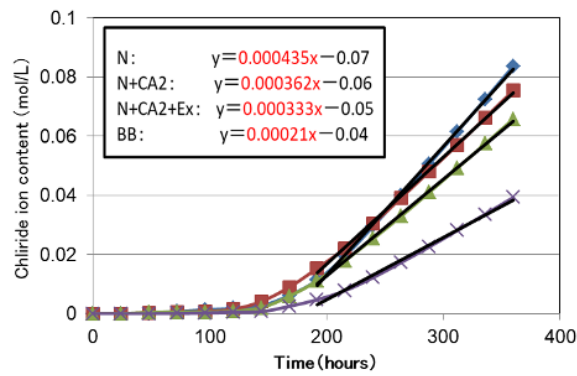
Figure 10. Steady-state electrophoresis test